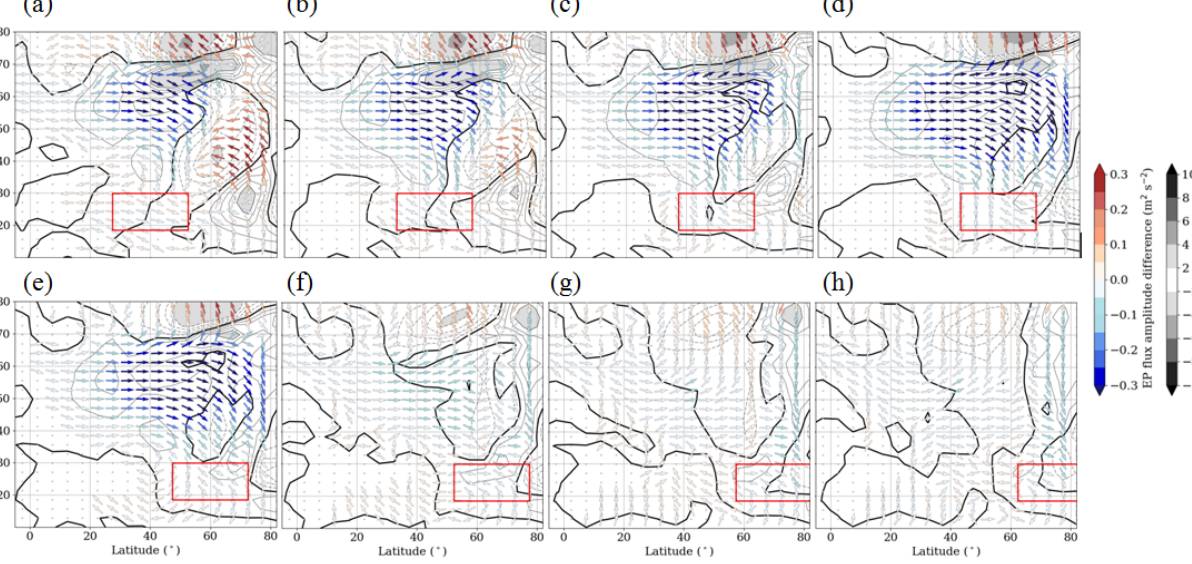
Figure 10. Zonal mean EP flux (arrows) and divergence (isolines and shaded areas; dashed lines show negative values) of SPW 1. Shown is the difference between all H1–H8 simulations (a–h) and the reference simulation (H1–H8 − Ref) representing the last 30d of the